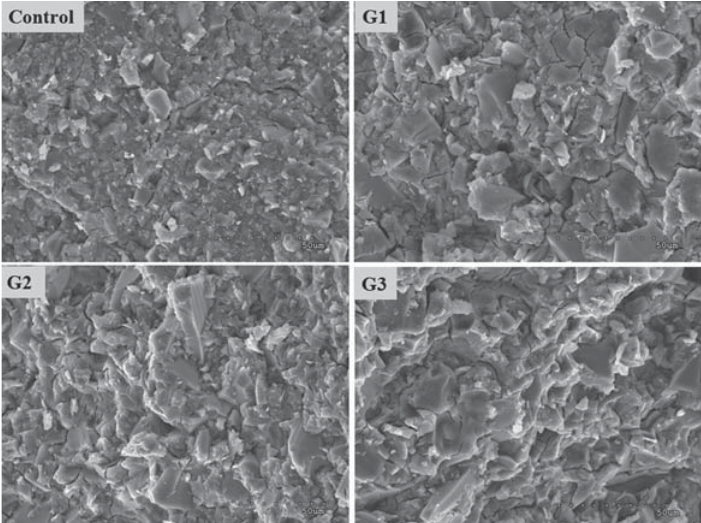
Figure 4- Scanning electron microscopy micrographs of the fractured surface of the cements matured for 7 days in